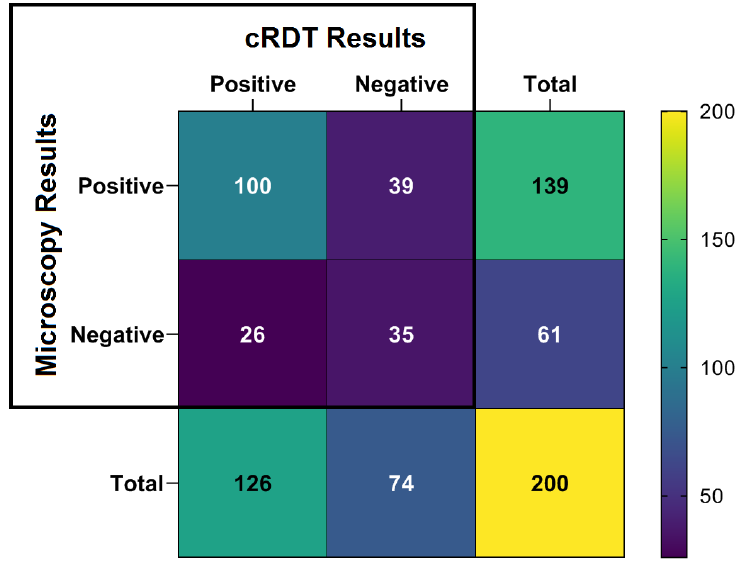
Figure 2. Confusion matrix for malaria positive and negative cases between microscopy (Gold standard) and the conventional rapid diagnostic test (cRDT) (SD Bio line Malaria Ag P.f